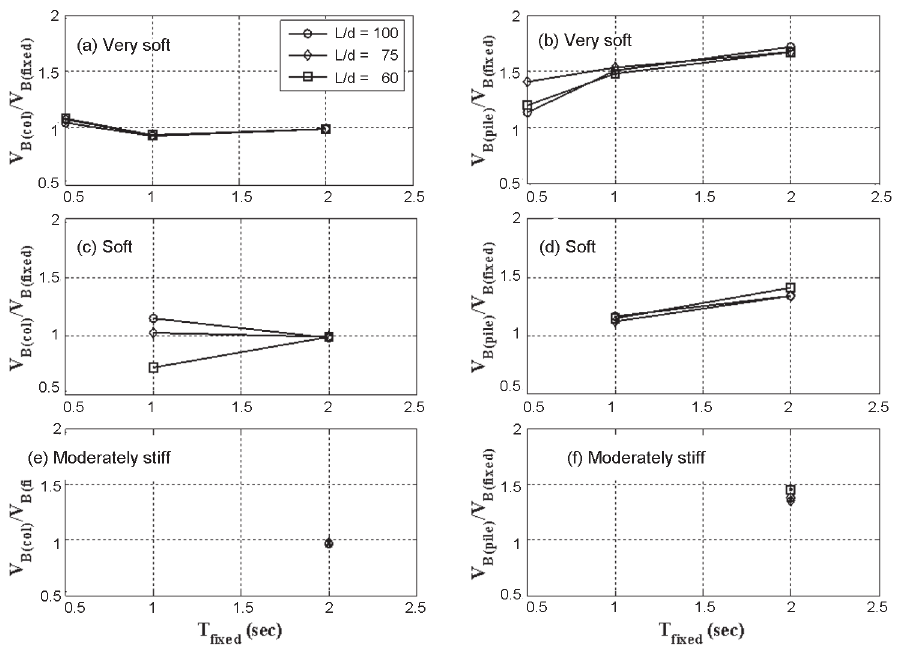
Fig. 8. Variations of normalised base shear for constant soil modulus for different L/d ratios: a) V B(col) / V B(fixed) versus T fixed for very soft soil; b) V B(pile) / V B(fixed) versus T fixed for very soft soil; c) V B(col) / V B(fixed) versus T fixed for soft soil; d) V B(pile) / V B(fixed) versus T fixed for soft soil; e) V B(col) / V B(fixed) versus T fixed for moderately stiff soil; f) V B(pile) / V B(fixed) versus T fixed for moderately stiff soil